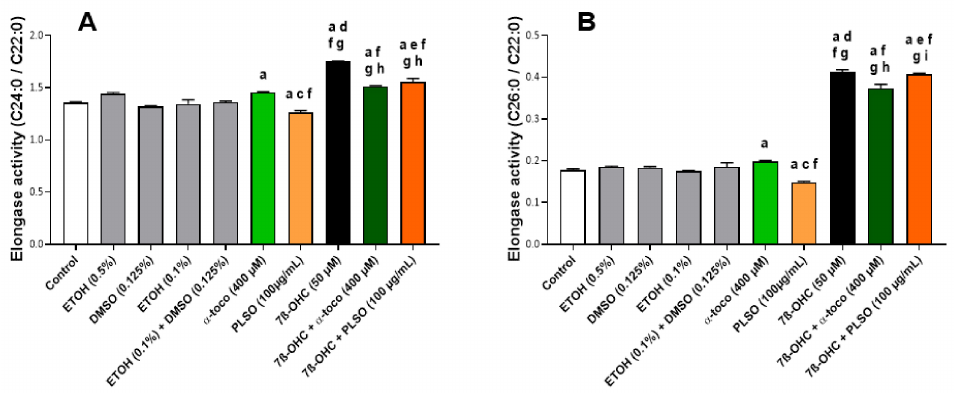
Figure 7. Effectof Pistacialentiscus L.seedoil ( PLSO ) and7 β -hydroxycholesterolonelongaseactivities. C2C12 cells were incubated for 24 h with or without 7 β -OHC (50 µ M) in the presence or absence of PLSO (100 µ g/mL) or α -tocopherol (400 µ M). The levels of C22:0, C24:0, and C26:0 were determined by GC-MS, and the corresponding elongase activity index, which could correspond to ELOVL1, 3, and 6 activity (ratio (C24:0/C22:0) ( A ) and ratio (C26:0/C22:0) ( B )) were calculated. Data are the mean ± SD of two independent experiments. A multiple comparative analysis between the groups, taking into account the interactions, was carried out using an ANOVA test followed by a Tukey’s test. A p -value less than 0.05 was considered statistically significant. The statistically significant differences between the groups, which are indicated by different letters, take into account the vehicle used. a: comparison versus control; b: comparison versus ETOH (0.5%); c: comparison versus DMSO (0.125%); d: comparison versus ETOH (0.1%); e: comparison versus (ETOH (0.1%) + DMSO (0.125%)); f: comparison versus α -toco (400 µ M); g: comparison versus PLSO (100 µ g/mL); h: comparison versus 7 β -OHC (50 µ M); i: comparison versus 7 β -OHC (50 µ M) + α -toco (400 µ M). No significant differences were observed between the untreated (control) and vehicle-treated cells.